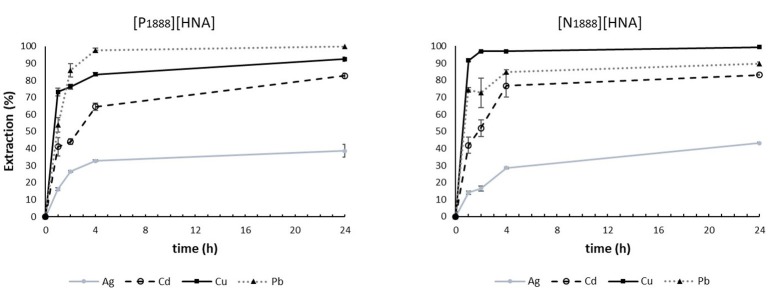
Time dependency of extractions using 300 mg of [P1888][HNA] or [N1888][HNA] in 30 mL “pure water” feed solution. n = 3, error bars = ± SD.